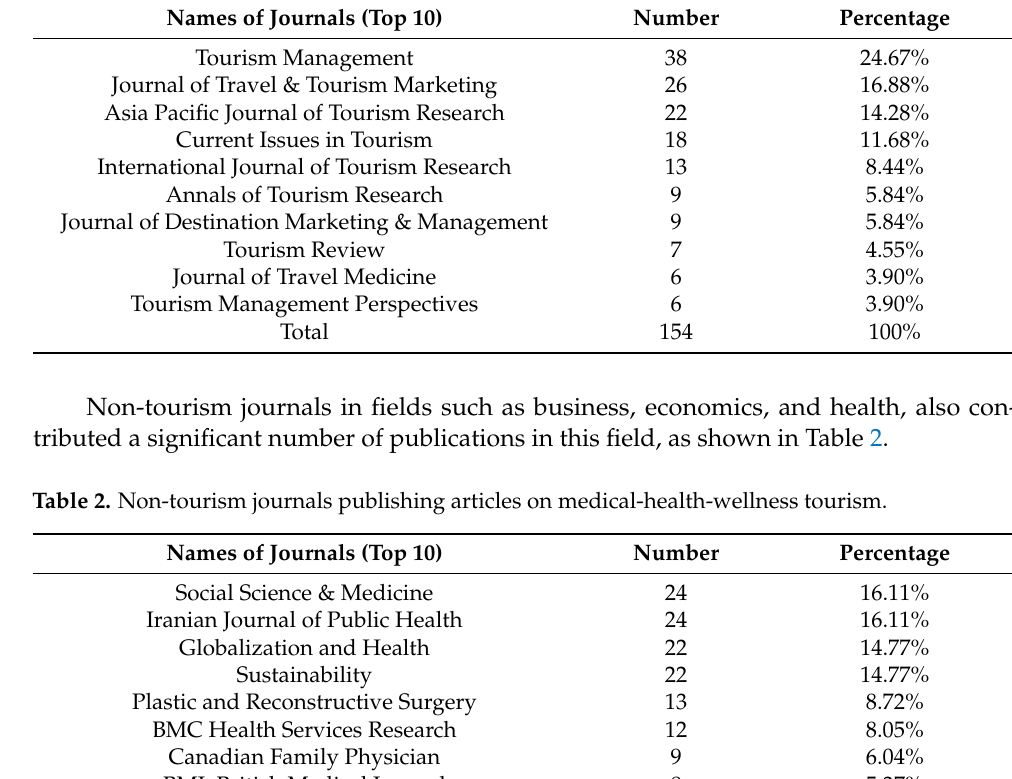
Table 1. Tourism journals publishing articles on medical-health-wellness tourism.